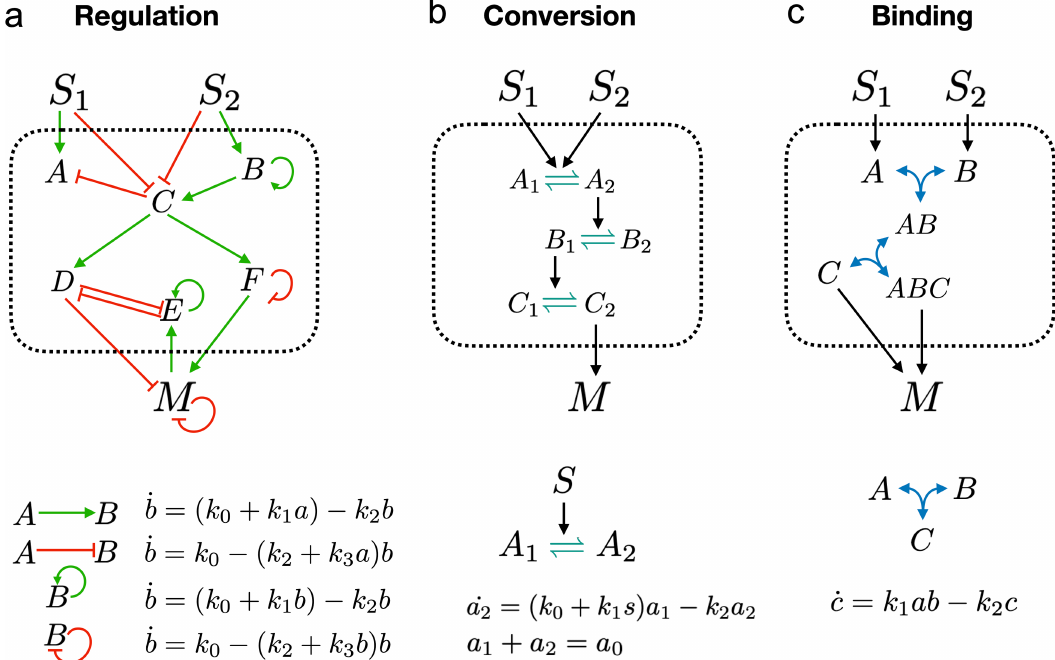
Fig. 3 Mathematical modeling. For networks containing one of three possible types of interaction, a regulation, b molecular conversion, or c reversible binding, we model the dynamics using deterministic rate equations, as shown. For each network we calculate the steady state m ( s 1 , s 2 ), which determines how the output M changes with the inputs S 1 , S 2 . To focus on network topology, we set rates (the k i ) and conserved quantities (like a 0 ) to 1 when assessing whether value antagonism or slope antagonism is